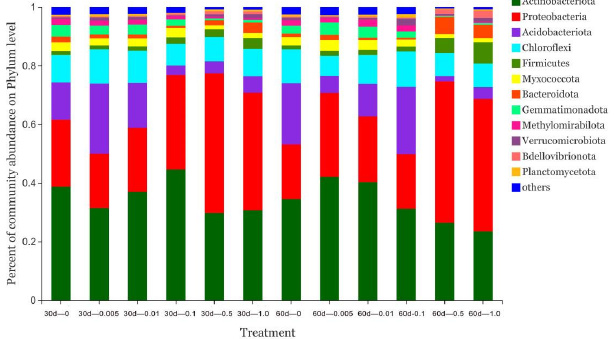
Figure 3. Effect of catechol on bacterial community composition. Note: In the figure, 30d and 60d indicate 30 days and 60 days of culture, respectively. 0, 0.005, 0.01, 0.1, 0.5, and 1.0 respectively, indicate the concentration of exogenous acid (in mol/L). The same below.